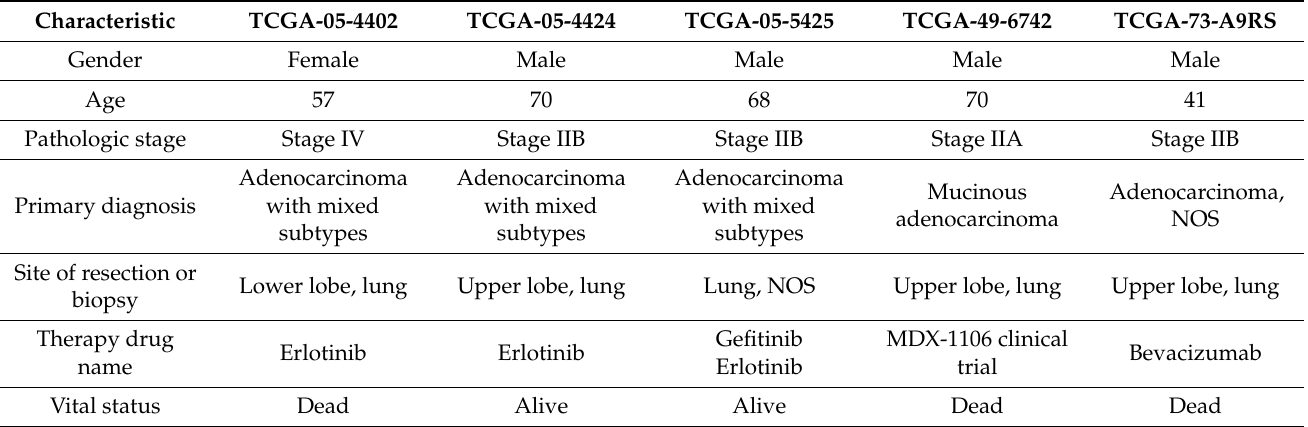
Table 2. The characteristics of TCGA